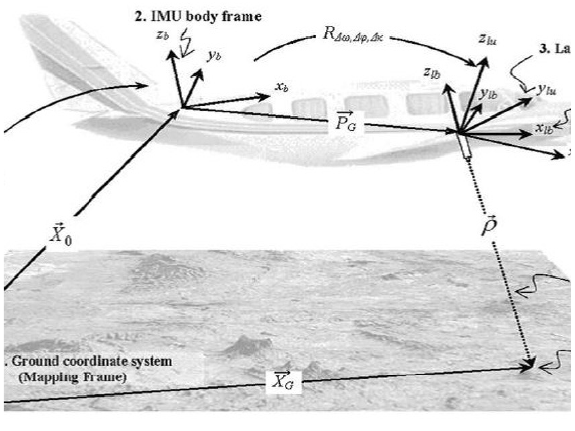
Figure 1: LiDAR data